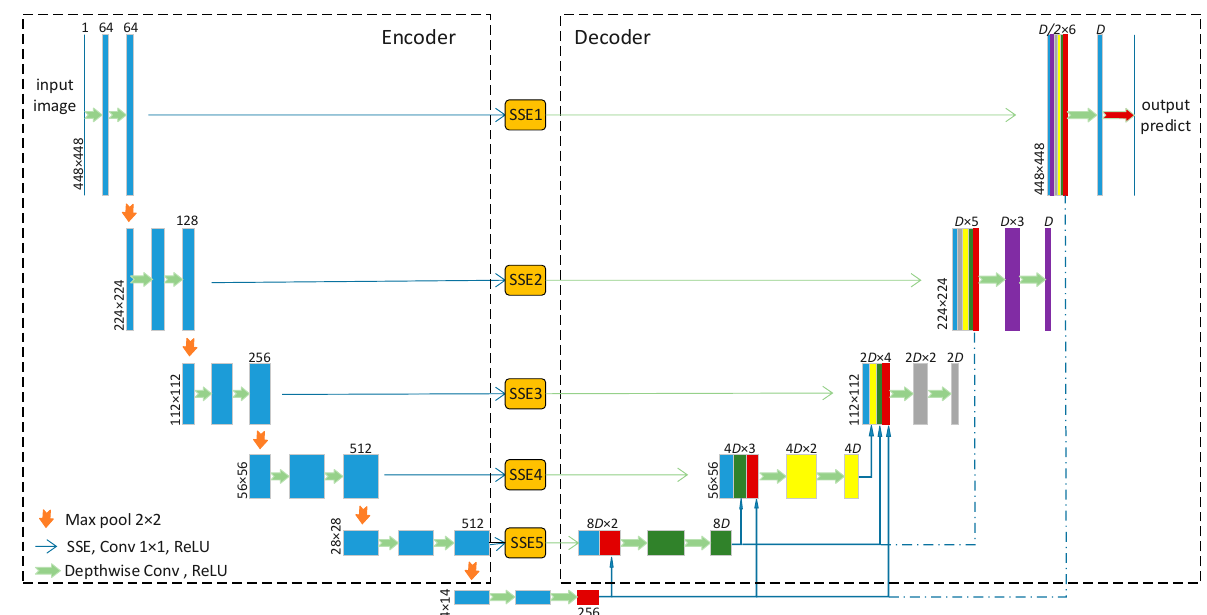
Figure 1. Structure of SCCDNet. SCCDNet consists of three parts: Encoder module, Decoder module, and SSE module. See text for details.